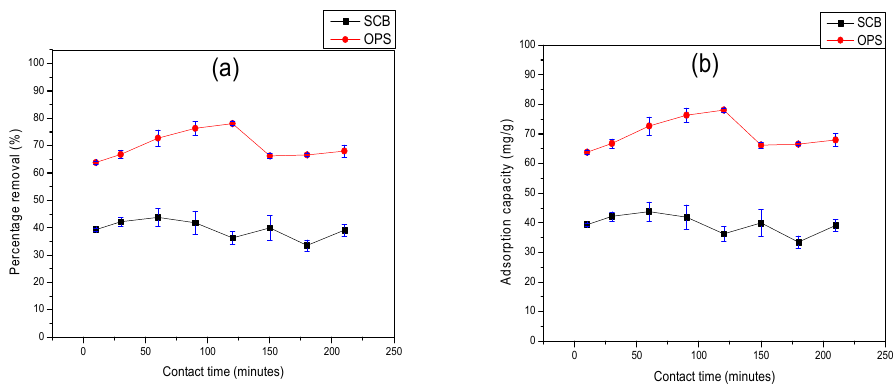
Figure 9. Effect of contact time: ( a ) 50 mg/L Pb(II) percentage removal and ( b ) 50 mg/L Pb(II) adsorption capacity.